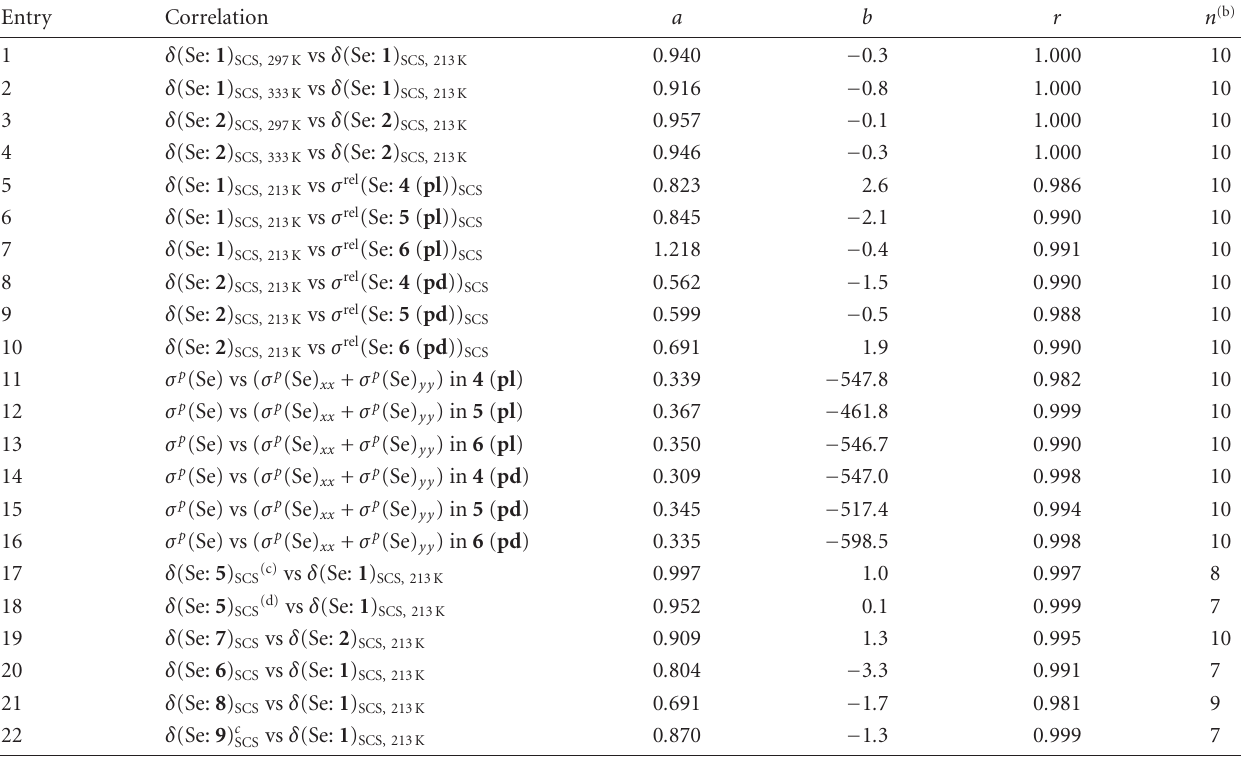
Table 2: Correlations of δ (Se) SCS for 1 and 2 and σ (Se) for 4 – 6 , together with δ (Se) SCS for 5 – 9 (a)